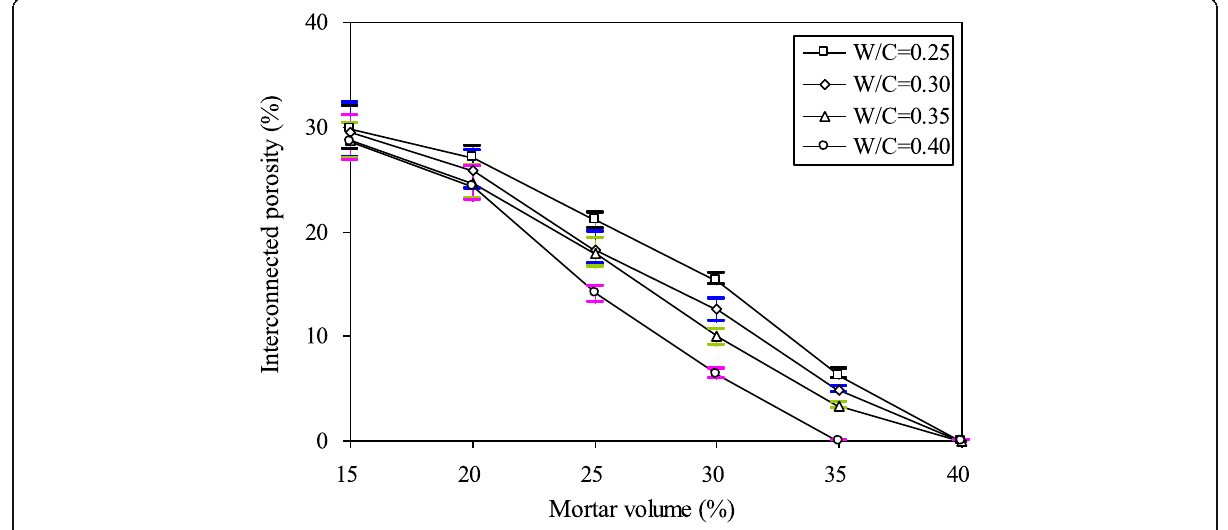
Fig. 5 Interconnected porosity versus mortar volume for different W/C